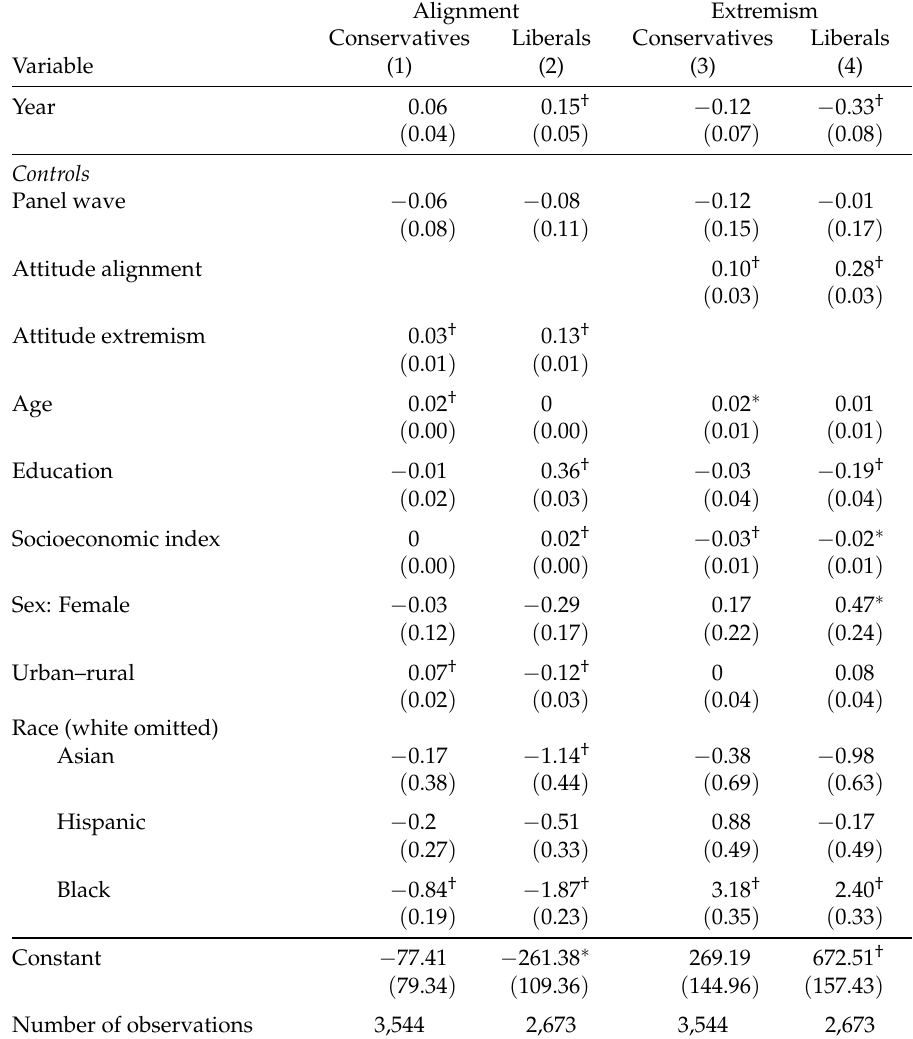
Table 4: HLMs predicting trends in attitude extremism and alignment, 2006 to 2014.